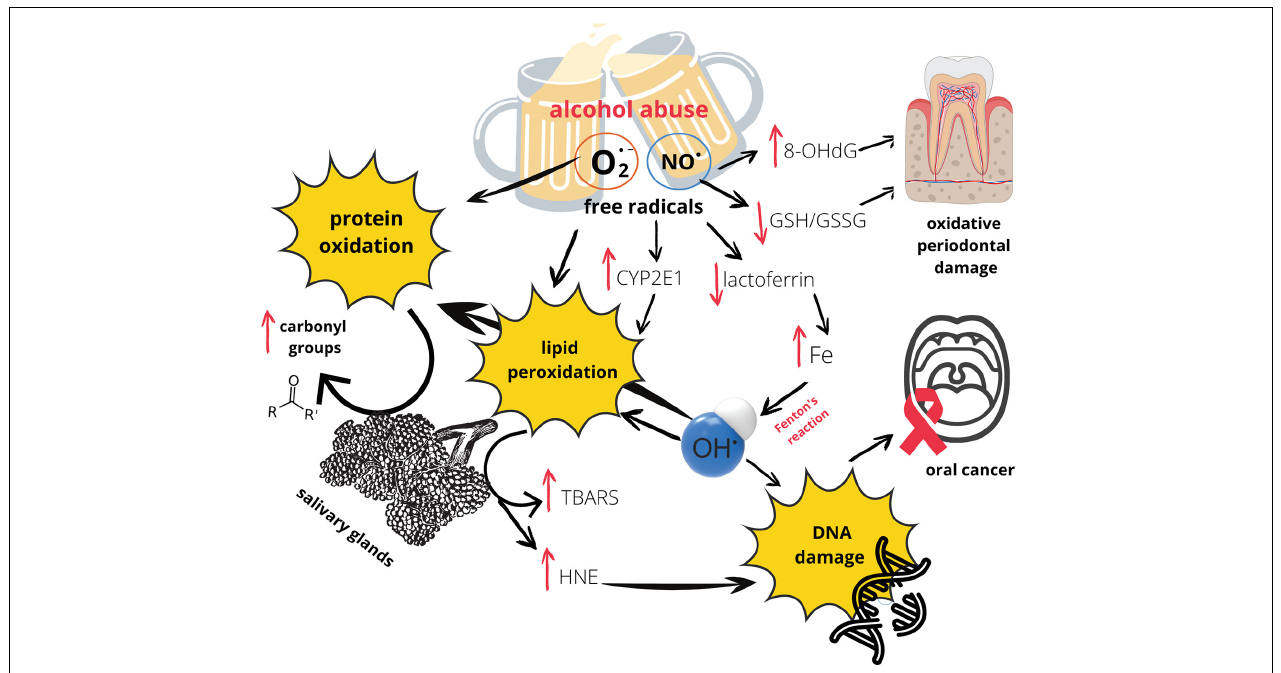
FIGURE 2 | Effects of alcohol abuse on oral redox homeostasis. 8-OHdG, 8-Hydroxy-2 (cid:48) -deoxyguanosine; CYP2E1, Cytochrome P450 2E1; GSH/GSSG, glutathione/glutathione disulfide; HNE, 4 hydroxynonenal; O 2 ·− , superoxide anion radical; NO · , nitric oxide; TBARS, thiobarbituric acid reactive substances.